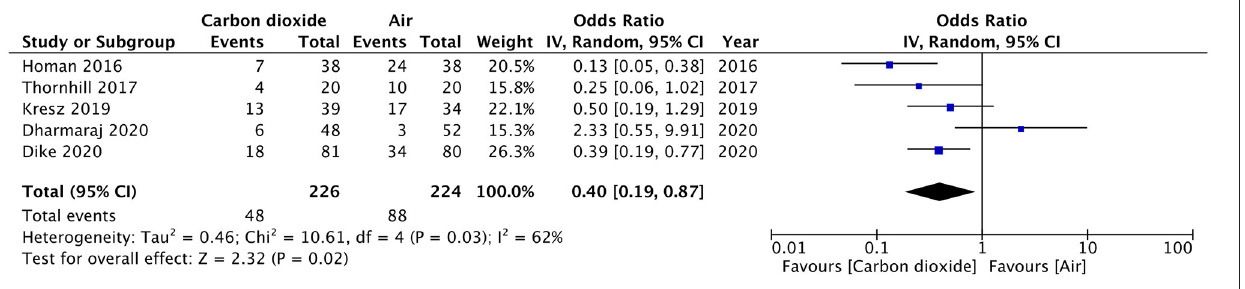
FIGURE 3 | Meta-analysis of incidence of pain after pediatric GI endoscopy with CO 2 and air.